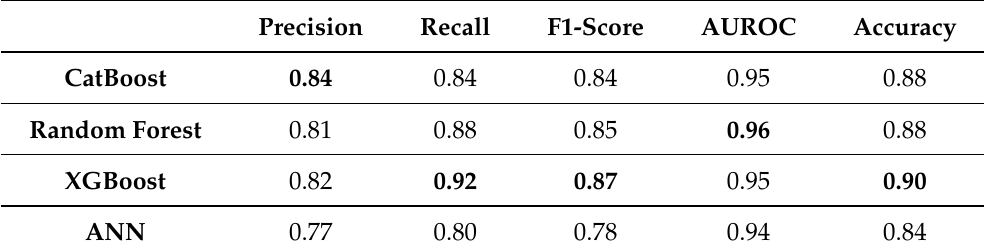
Table 5. Comparison between the different models’ predictions on the final test